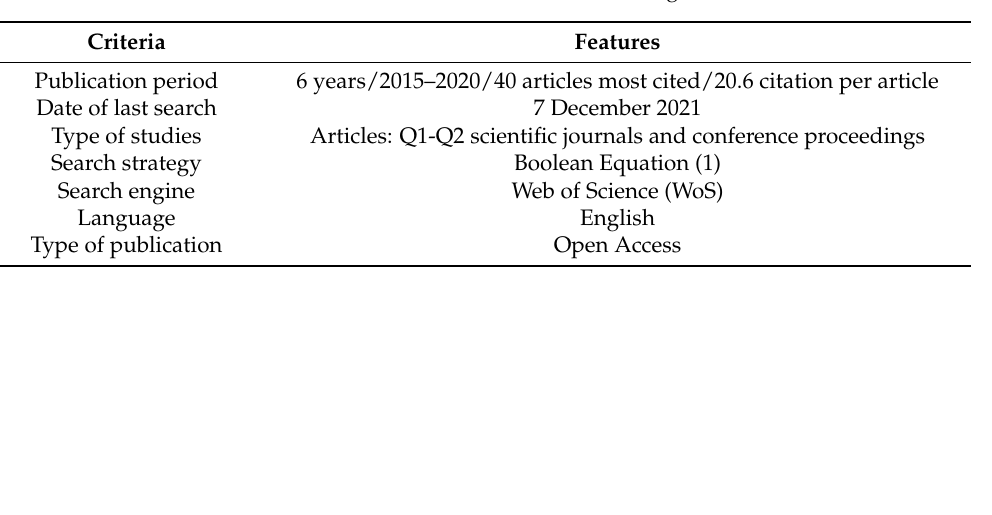
Table 1. Selection criteria and main characteristics of aluminium, magnesium or titanium